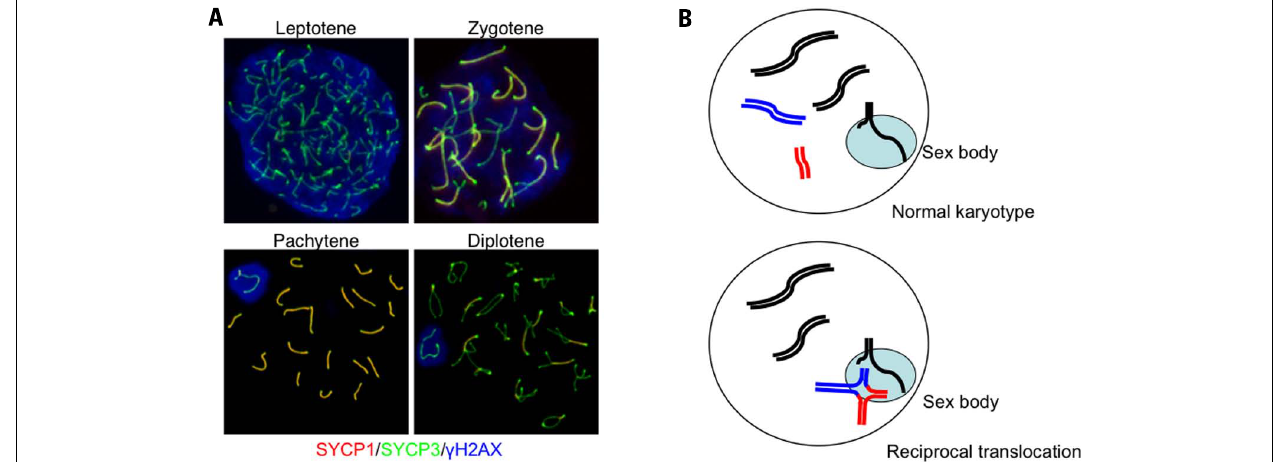
chromosomes cannot complete synapsis and remain green.The unsynapsed X andY chromosomes are confined within the γ H2AX-stained nuclear domain (blue). (B) Diagrams illustrating the autosome–sex body association.The upper panel shows sex body formation during normal spermatogenesis. Unsynapsed regions of the X andY chromosomes are confined within the sex body (light blue). In male translocation carriers (lower panel), translocated chromosomes form quadrivalents (red and blue lines), which often have unsynapsed regions around the breakpoints, that become associated with the sex